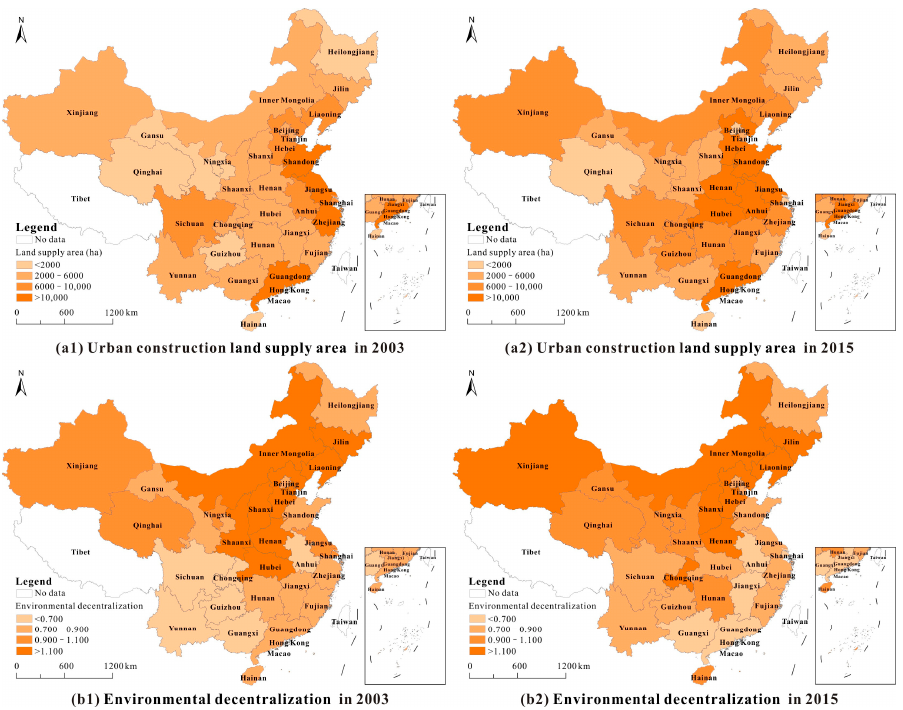
Figure 2. Temporal and spatial evolution of urban construction land supply and environmental decentralization.